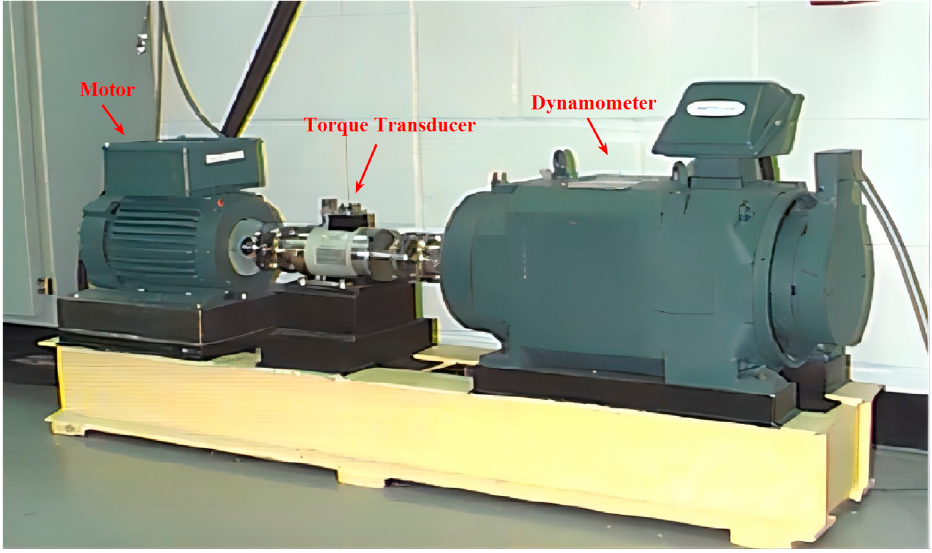
Figure 5. Case Western Reserve University bearing dataset collection platform.